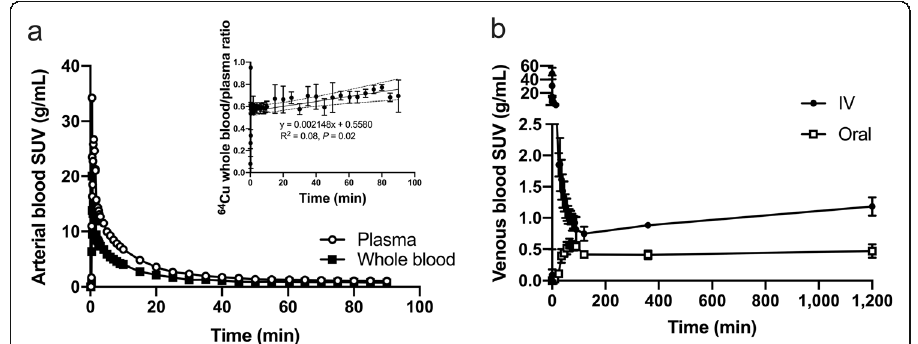
Fig. 3 Time courses of the concentration of 64 Cu in blood following administration intravenous (IV) and oral administration. Panel a shows SUV in arterial whole blood (closed circles) and plasma (open circles) following the initial 90min after IV administration of 64 Cu ( n =3; for clarity, no error bars are displayed); displayed as insert is the ratio between radioactivity concentration in whole blood and plasma. Panel b shows SUV in venous whole blood following IV and oral administration of 64 Cu ( n =4 and n =2, respectively). Values are given as group means ±